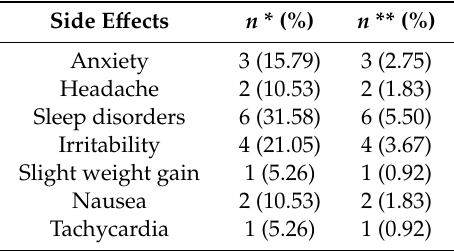
Table 4. Distributions of side e ff